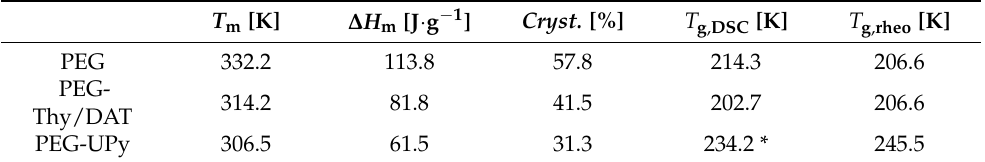
Table 9. Rheological glass transition T g,rheo , calorimetric glass transition T g,DSC , melting temperature, T m , melting enthalpy, ∆ H m and crystallinity degree for PEG polymer, PEG-thy/dat and